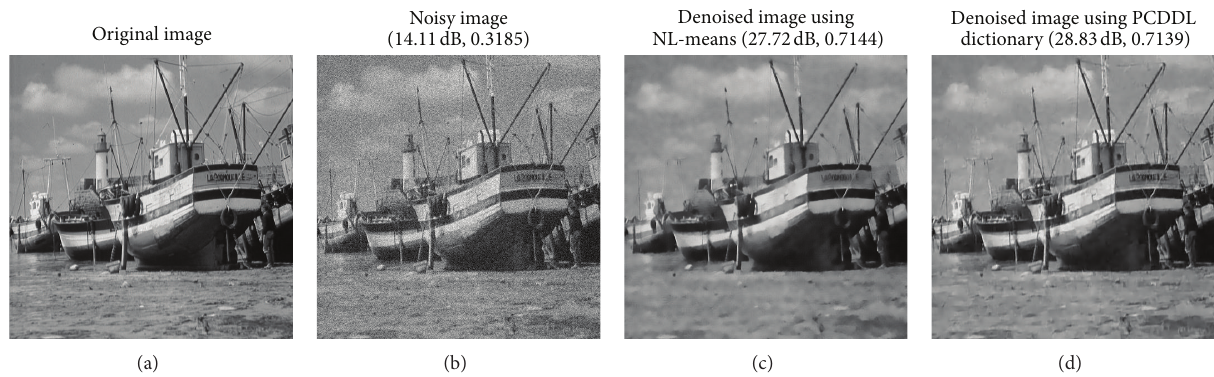
Figure 7: Example of denoising results for the image “Boat” with a noise level of 14.11dB. In brackets, the former items denote PSNR values, and the latter items denote the SSIM index.